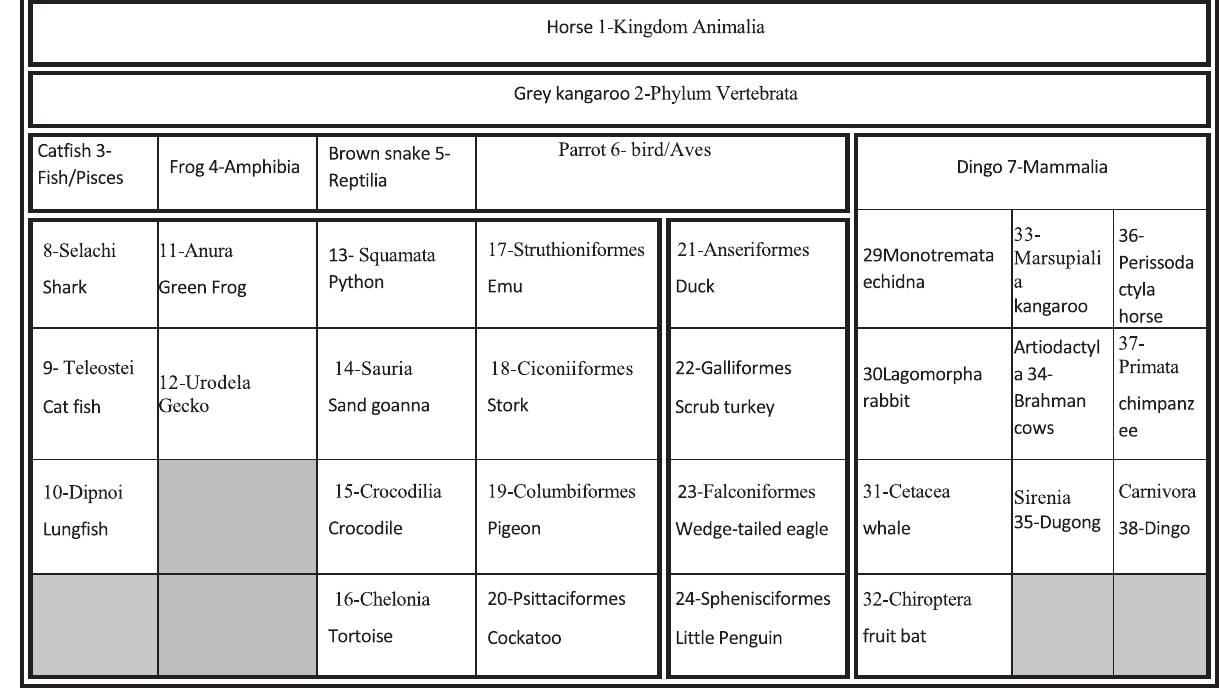
Fig. 1. Modified Montessori materials: Koora style First Classification of Animal Kingdom Chart (only pictures of the